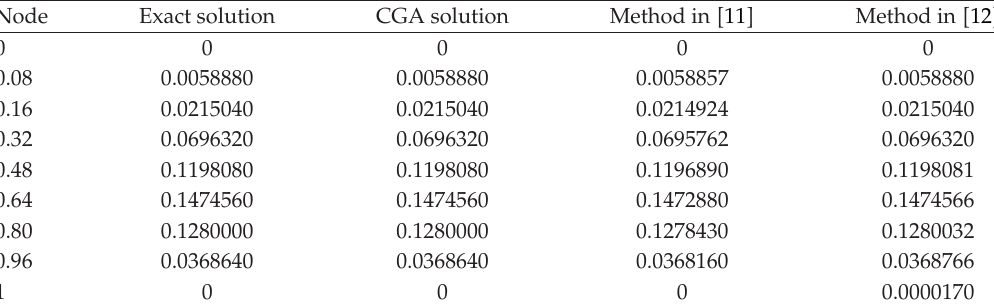
Table 16: Numerical comparisons of approximate solution for Problem